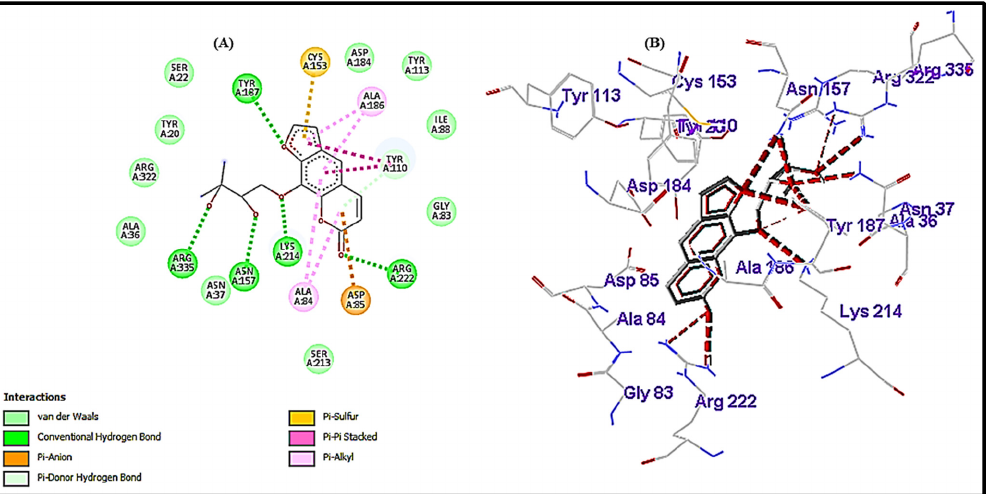
Figure 7. Scanning electron microscopic images of Escherichia coli MTCC 739 biofilms: ( A ) 24 h old control samples and ( B ) treated with heraclenol. Heraclenol was used at MIC value.